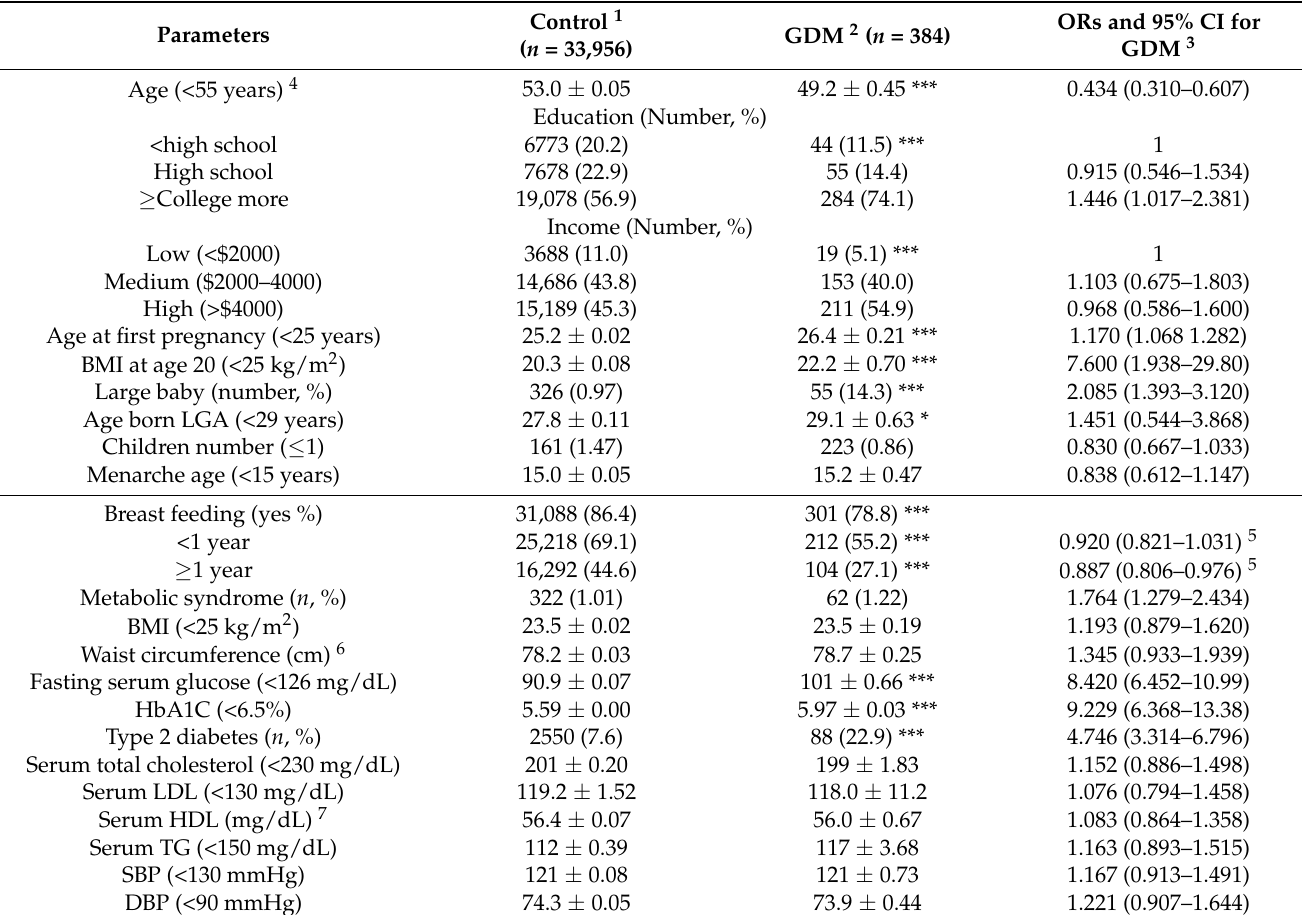
Table 1. General characteristics of gestational diabetes mellitus (GDM) patients and adjusted odds ratio (OR) and 95% confidence intervals (CI) for GDM or type 2 diabetes (T2DM) in later